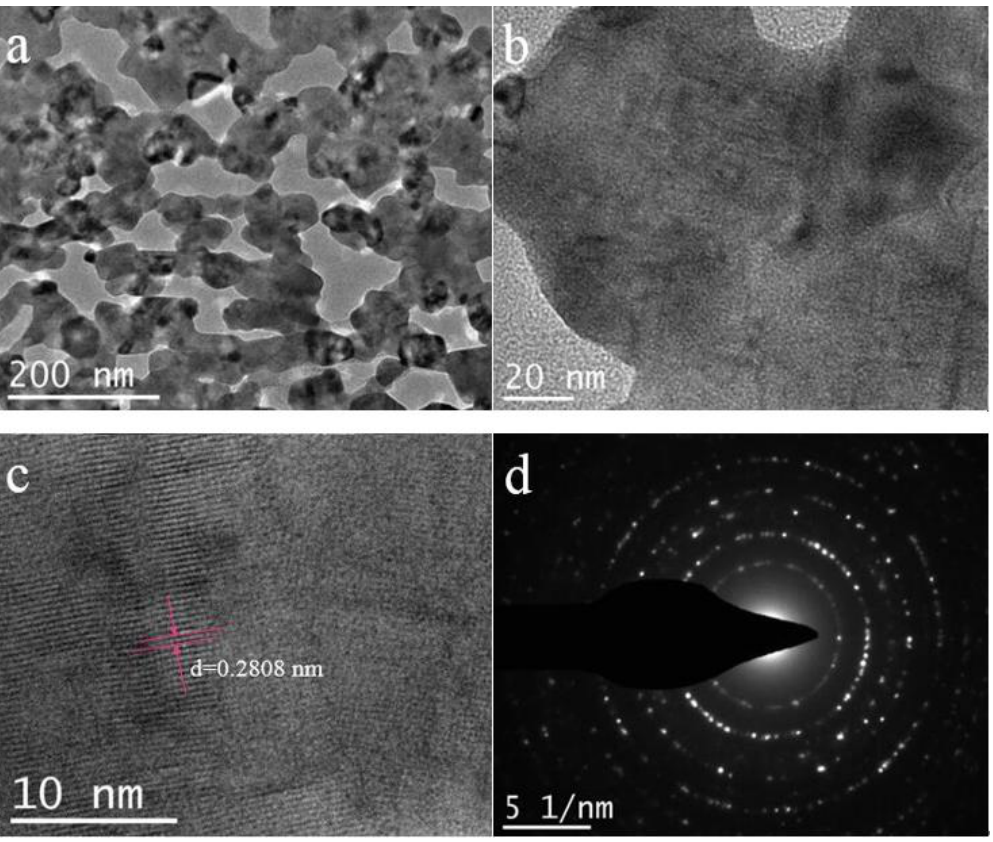
Figure 4. ( a , b ) TEM, ( c ) High resolution TEM (HRTEM) and ( d ) Selected area electron diffraction (SAED) images of LSNO-0.4 sample.